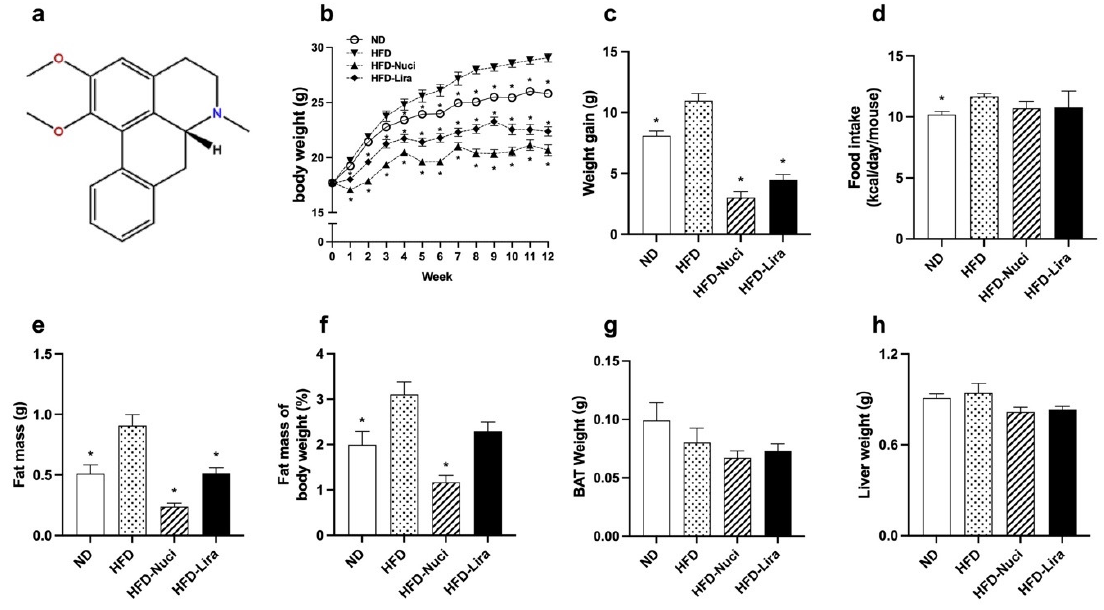
Figure 1. Nuci prevented obesity in HFD-fed mice. ( a ) The molecular structure of Nuci. Seven-weeks male C57BL/6J mice were fed with ND, HFD, HFD supplemented with Nuci and HFD with subcutaneous injection of Lira at 200 µ g/kg/day for 12 weeks, body weight ( b ) and energy intake ( d ) were recorded, and body weight gain ( c ) was calculated by the end of the experiment. The amount of fat mass ( e ), including sWAT, eWAT, and pWAT, as well as the weight of BAT ( g ) and liver ( h ) were recorded. Fat mass of body weight ( f ) was calculated by dividing the sum of fat mass by body weight. Data were presented as mean ± SE, n = 12 in each group. * p < 0.05 vs. the HFD